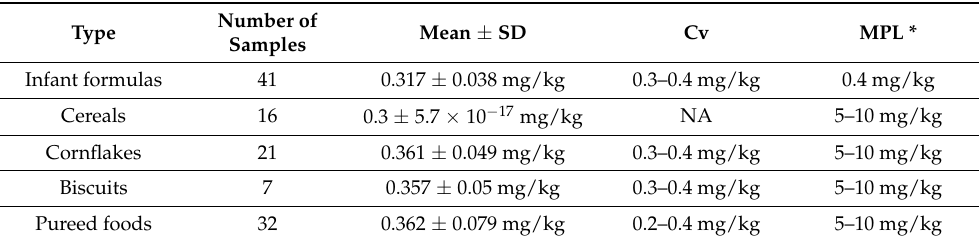
Table 3. Concentration of aluminum in infant powdered formula and in food products of children under the age of